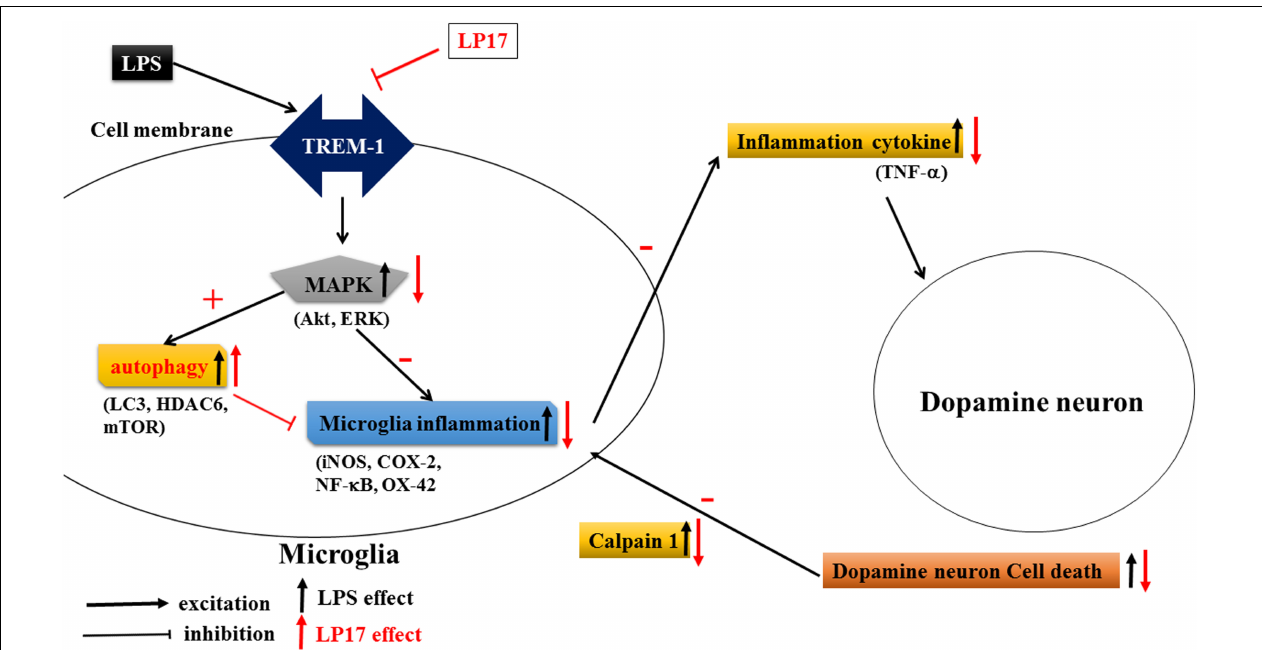
FIGURE 10 | Putative mechanism of action of TREM-1 in LPS-induced neuroinflammation and 6-OHDA-induced neuron cell death. LPS increases the upregulation of TREM-1 protein expression. Downstream MAPK proteins further activate microglial inflammatory processes such as the translocation of NF- κ B and upregulation of iNOS and COX-2. Then, the overactivated microglia release various neurotoxic factors such as TNF- α that damage dopamine neurons. These damaged neurons release extracellular calpain-1, further stimulating the microglia and continuing the cycle of neurotoxic microglial activation in response to neuron injury. In our study, the LP17 peptide not only significantly attenuated LPS-induced inflammation process but also enhanced autophagy as indicated by an increase in the LC3-II/LC3-I ratio, upregulation of HDAC6 expression, and downregulation of mTOR. The diminishment of microglial activation may lead to the downregulation of neurotoxic factors and may protect cells against damage. Moreover, LP17 attenuated extracellular calpain-1 release to alleviate the further activation of